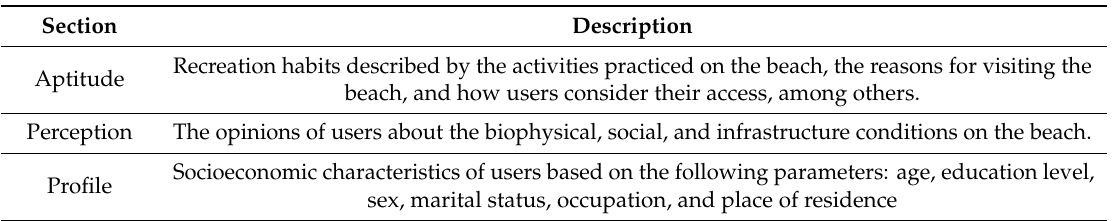
Table 1. Types of information obtained from the perception surveys carried